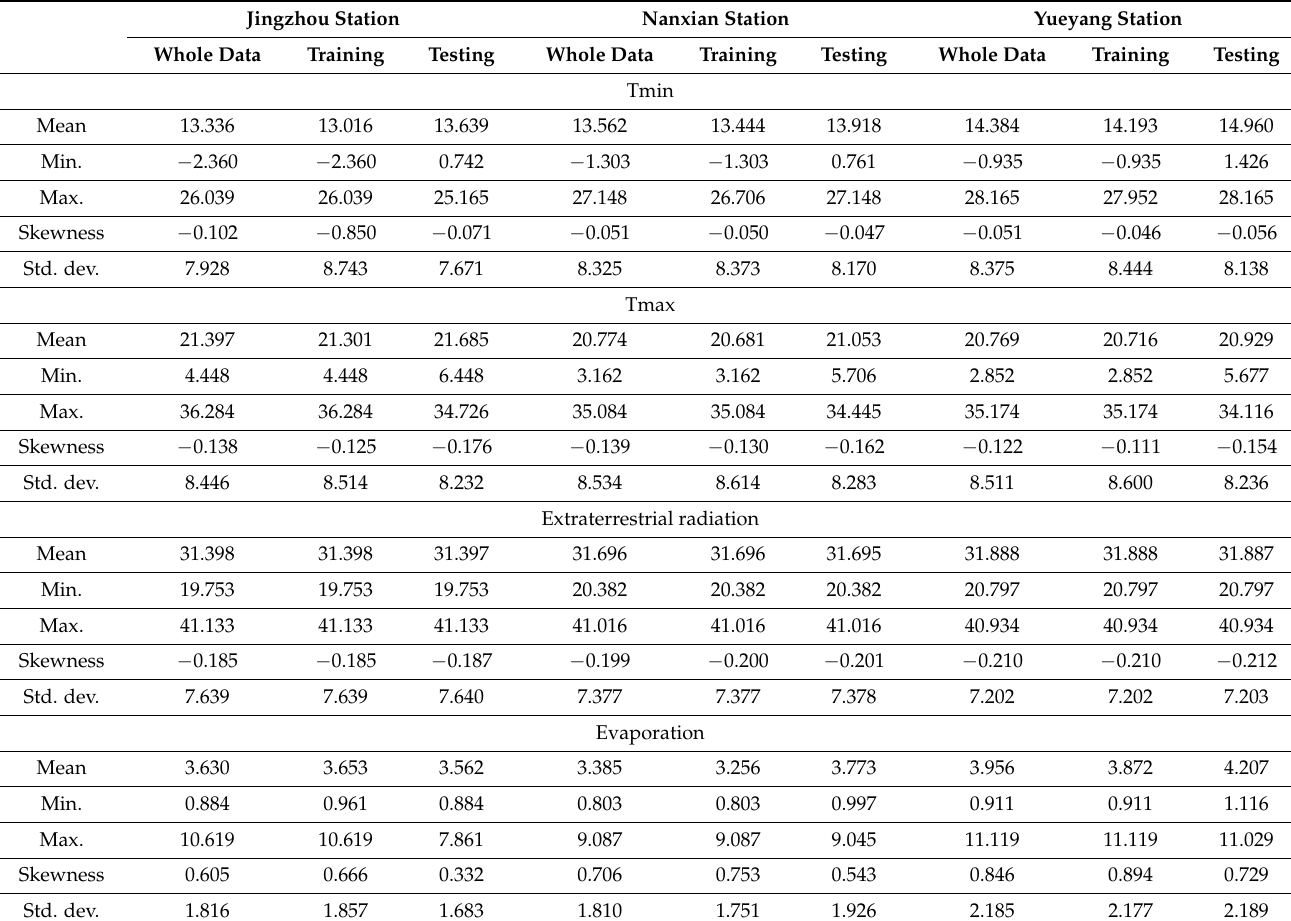
Figure 1. The Dongting Lake basin and the study stations (Jingzhou, Nanxian, and Yueyang) in southern China. Table 2. The statistical characteristics of the data used in this study.